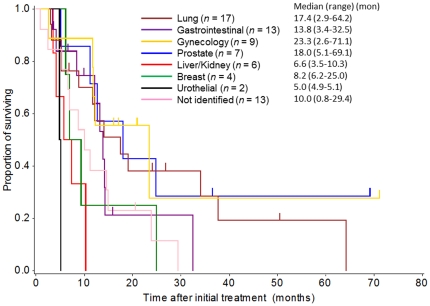
Overall survival curve by the Kaplan-Meier method for the groups with each primary site as classified by the immunohistochemistry profiles.